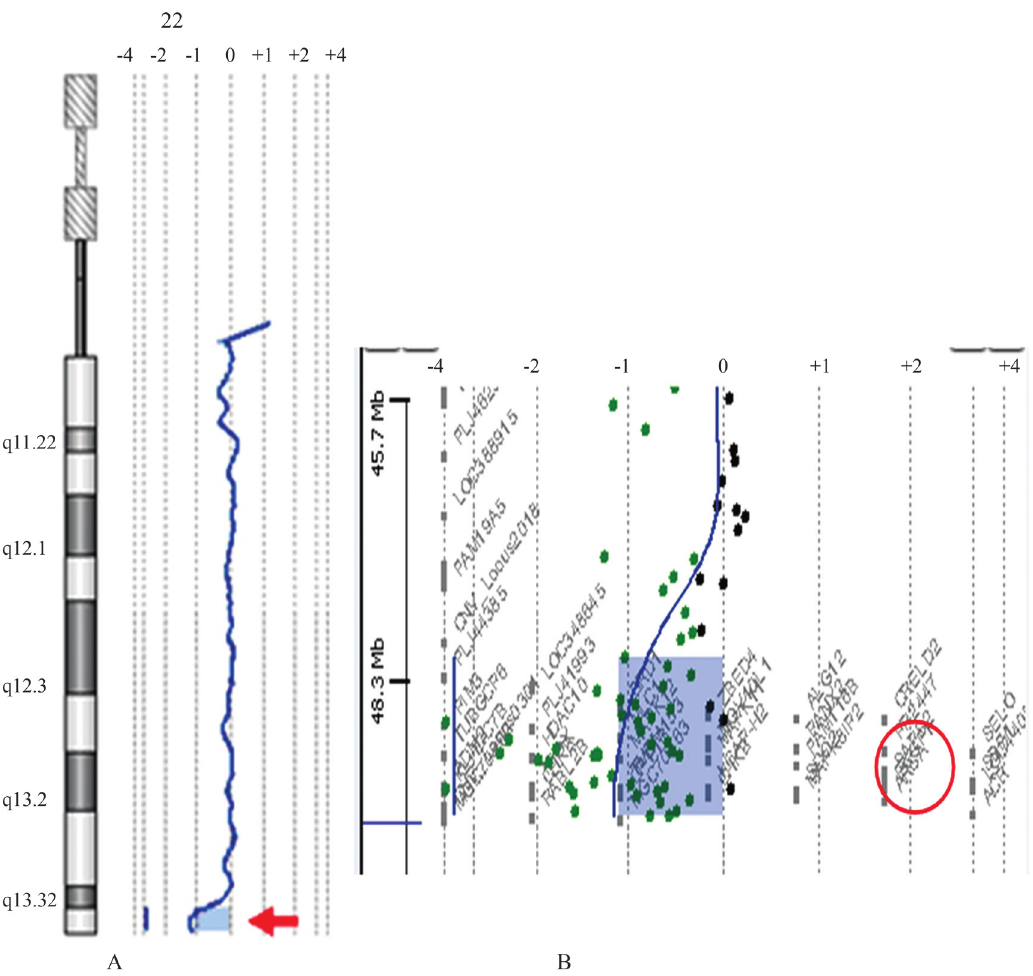
Figure 2 - Chromosome 22 array-CGH profile of the propositus (normal male as a reference DNA). (A) The probe log 2 ratios were plotted according to genomic coordinates (based on the UCSC Genome Browser, February 2009, NCBI Build 37 reference sequence). A deletion (copy number loss) was de- tectedonthedistal22qregion(redarrow)inagenomicsegmentwithmedianlog 2 ratioshiftedto<-0.8.(B)Detailofthe22qsubtelomericregionshowing the deletion of ~1.4 Mb segment which includes the ARSA gene (red circle). The minimum deleted segment was mapped between chr22:48138838 (first aberrant probe) and chr22:49525130 (last aberrant